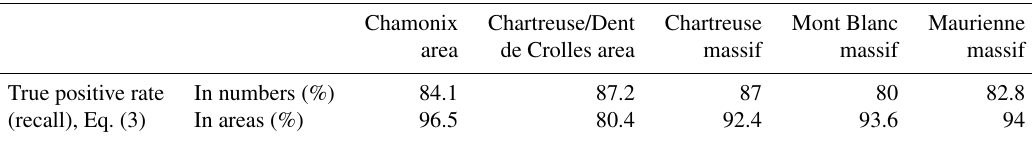
Table 4. Summary of true positive rates calculated in numbers and areas for the different areas and massifs. For the PRA detection and the determination of the validation sample, all factors and the DEM resolution are set to their default values (Figs. 3–4) and forest cover data are from DB forest